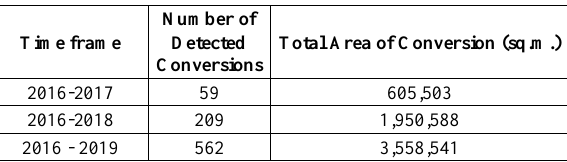
Table 7. Summary of Agricultural Land Conversion from 2016 to 2019